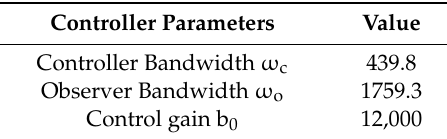
Table A2. Controller